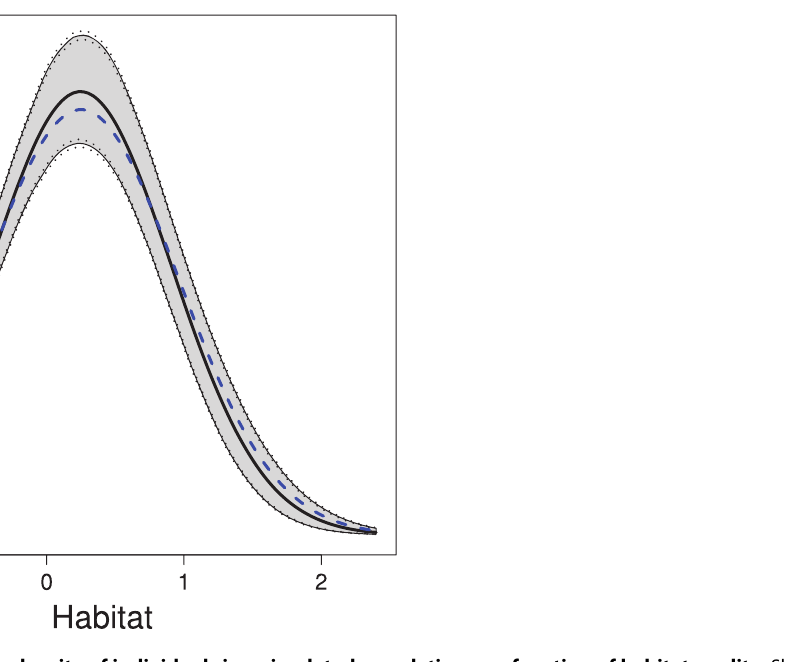
Figure 2. Predicted mean density of individuals in a simulated population as a function of habitat quality. Shaded region indicates 95% credible interval. Dotted lines indicate uncertainty of upper and lower credible limits due to Monte Carlo error. Blue dashed line indicates the true relationship between l ( s ) and habitat quality.